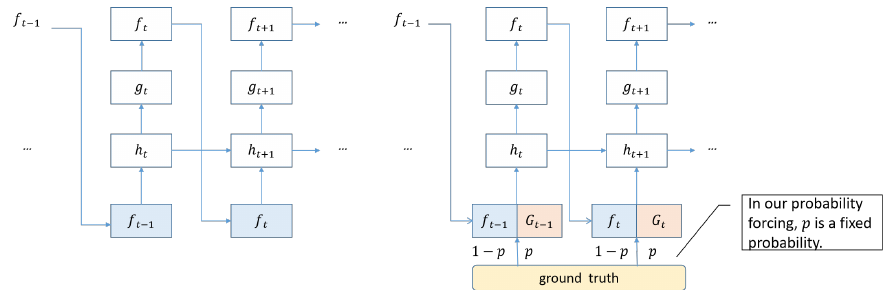
Figure 2. ( Left ) a general sequential prediction model directly uses predicted values of the previous step as input for the next step; ( Right ) a prediction model based on scheduled sampling uses the corresponding term of the ground truth of the training data instead of the output of the previous state as the input for the next state. The notation t is the current time step, f t − 1 is the predicted value of the previous step, h t is the hidden layer state of t time step, g t is the probability distribution obtained by decoding t time step, G t − 1 is the ground truth at t − 1 moment, p is the probability of feeding ground truth when mixing